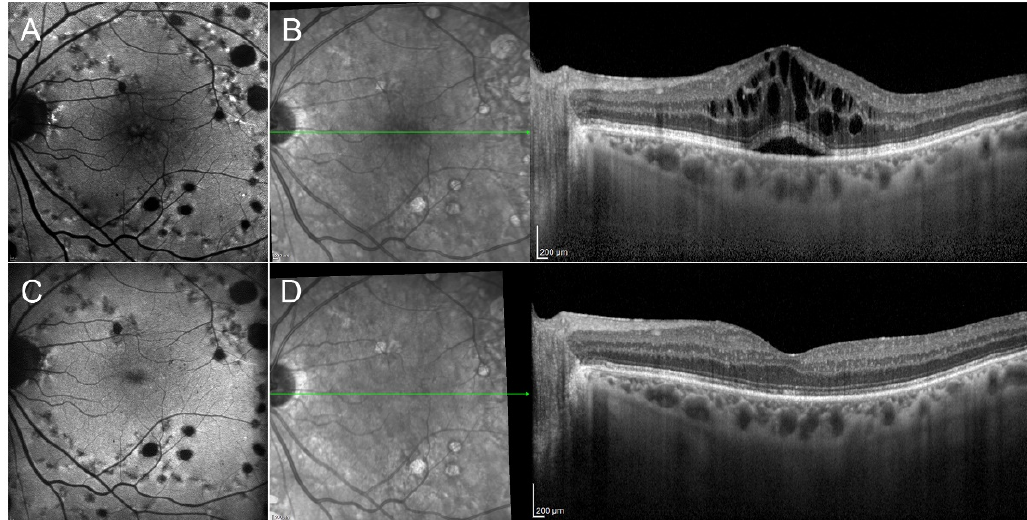
Figure 2. Clinical efficacy of dexamethasone implant in diabetic macular edema. The reported case has been already treated by laser, as shown by the hypoautofluorescent multiple spots ( A ), and it shows an evident macular edema with also the presence of subretinal fluid, detected on structural OCT ( B ). After a single dexamethasone implant, it is possible to observe the regression of the diabetic macular edema, with the complete recovery of the foveal profile ( C , D ).